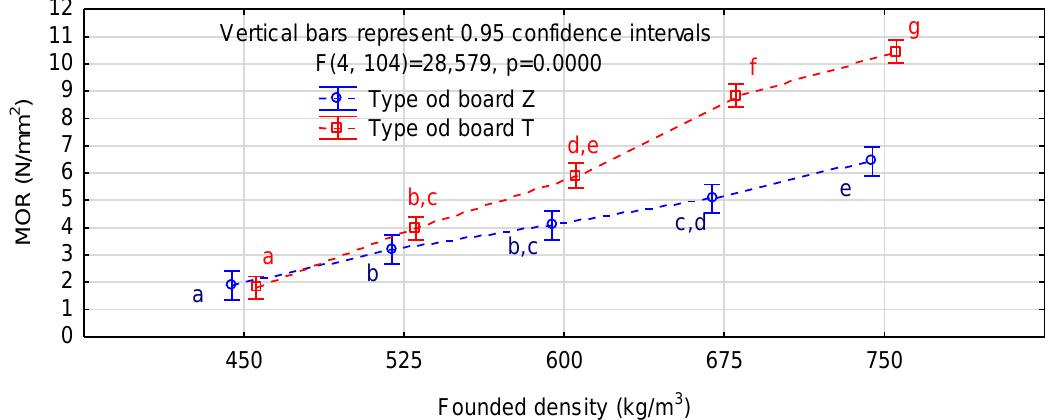
Figure 2. Interaction between density and mat structure and modulus of rigidity of the experimental boards (letters mark homogeneous groups in the HSD Tukey’s test).